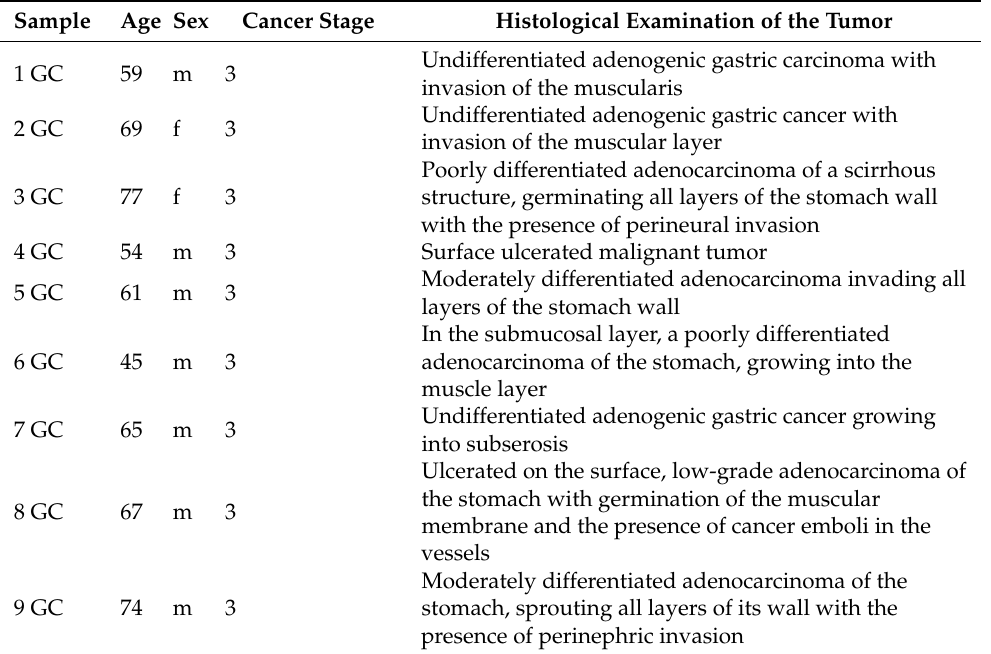
Table 1. Clinical and pathological characteristics of patients with gastric